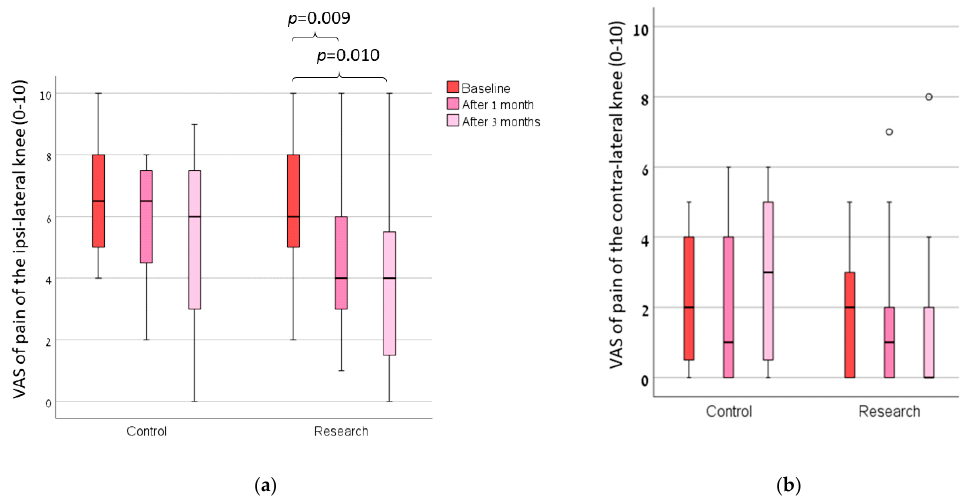
Figure 2. The Visual Analogue Scale of pain in the ( a ) ipsi-lateral and ( b ) contra-lateral knees of both groups at baseline, 1 month and 3 months after the baseline.